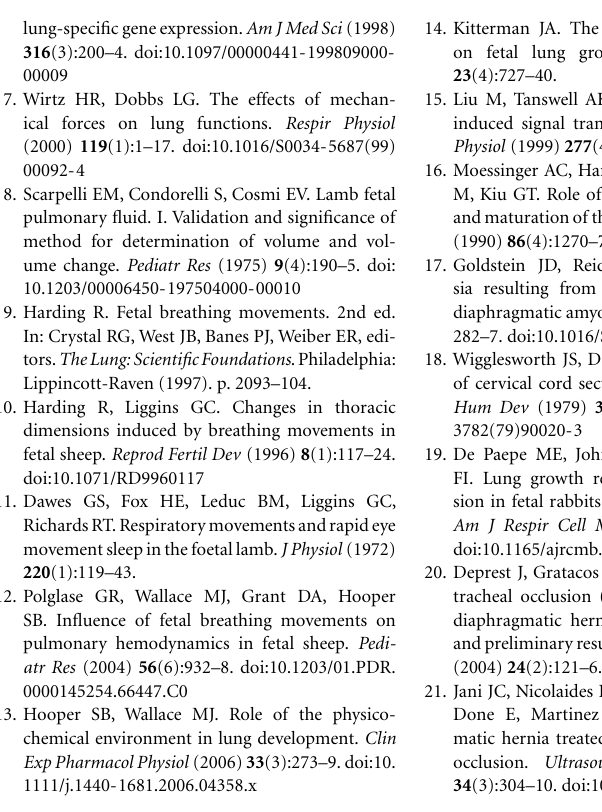
FIGURE 1 | Mechanistic model to show how mechanical forces promote differentiation of fetal type II epithelial cells via release of soluble growth factors HB-EGF andTGF- α with subsequent binding and activation of the EGFR and ERK signaling pathway